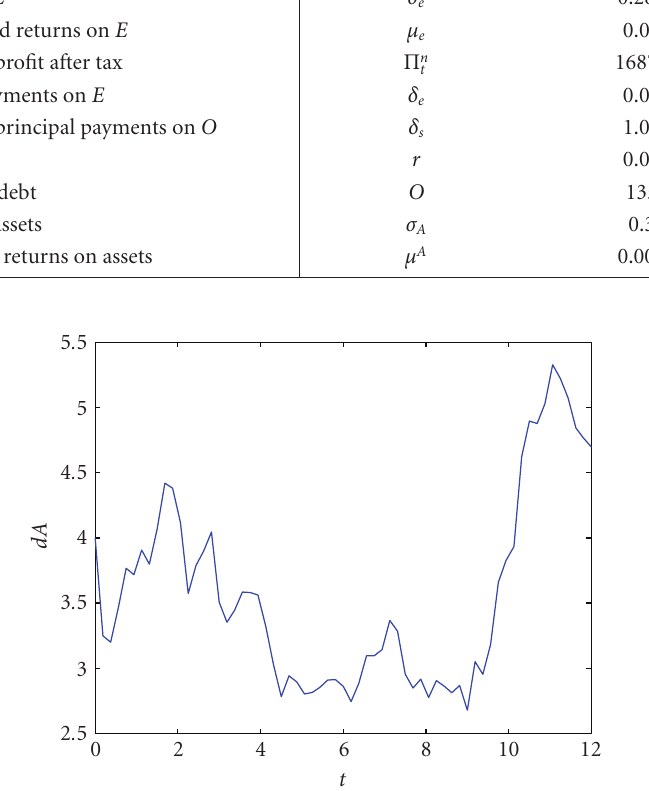
Figure 4.1. Trajectories of simulated